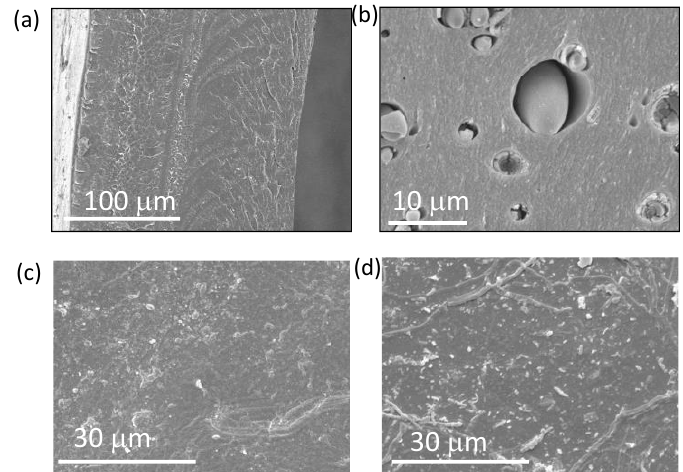
Figure 1. SEM images of the surface of the MF-4SC membrane ( a ) and composite membrane MF-4SC/PANI-3H* ( b ). SEM images of the cross section of an MF-4SC membrane ( c ) and composite membrane MF-4SC/PANI-3H* ( d ).